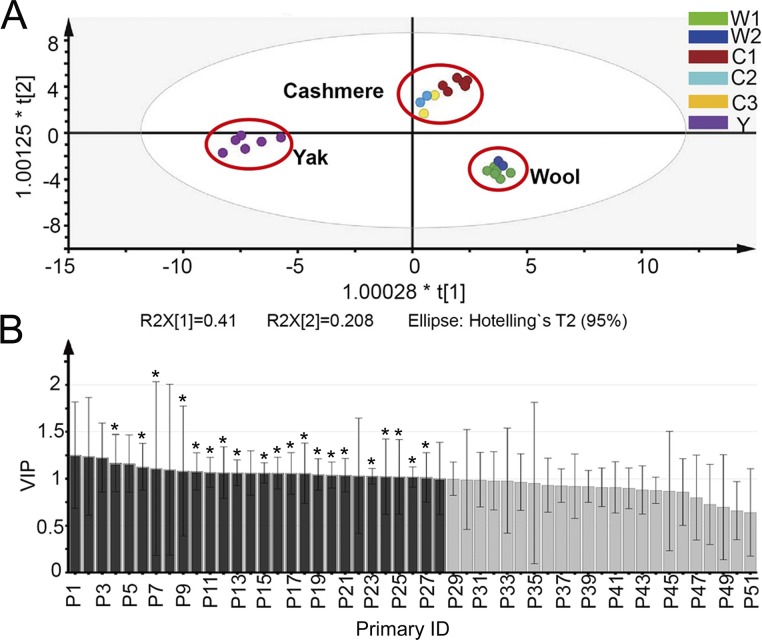
The PLS-DA analysis performed on quantified proteins from fiber standards.(A) The PLS-DA scores plot shows good separation of samples from different species, and samples from different breads of the same species are clustered together. (B) The variable influence on projection (VIP) plot shows that protein P1-P28 (with VIP value > 1) make most contribution to the separation of three groups in (A). Twenty out of the twenty-eight proteins also make significant discrimination in the ANOVA test (p<0.01) and they are marked with asterisks.